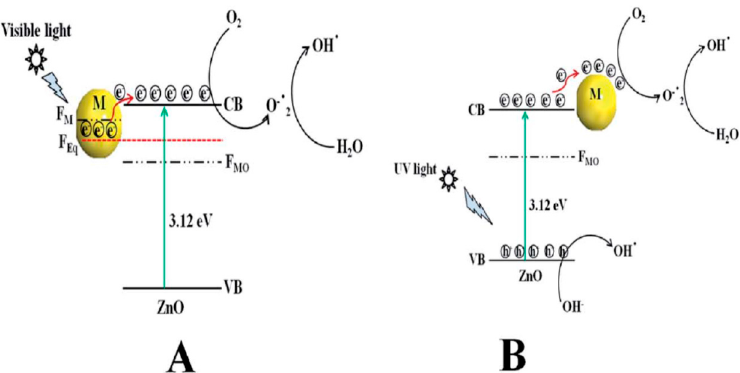
Figure 5. ( A ) Visible light induces localized surface plasmon resonance (LSPR) in AgNPs or AuNPs such that hot electrons are injected into the CB of ZnO for generating superoxide anion and hydroxyl radicals. ( B ) Under UV irradiation, photoexcited electrons are transferred from the CB of ZnO to AgNPs or AuNPs. VB = valence band, CB: conduction band, FMO: Fermi level of metal oxide, FM: Fermi level of metal, FEq: Fermi level of equilibrium, and M: Au and Ag. Reproduced from [127] with permission of the Royal Society of